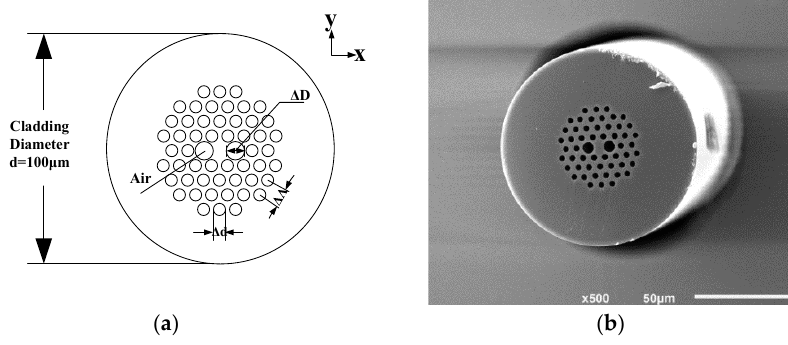
Figure 3. Solid core photonic crystal fiber used in the experiment ( a ) Drawing of the cross section ( b ) Scanning electron micrograph Table 1. Parameters of the experimental IFOG used in the computations.